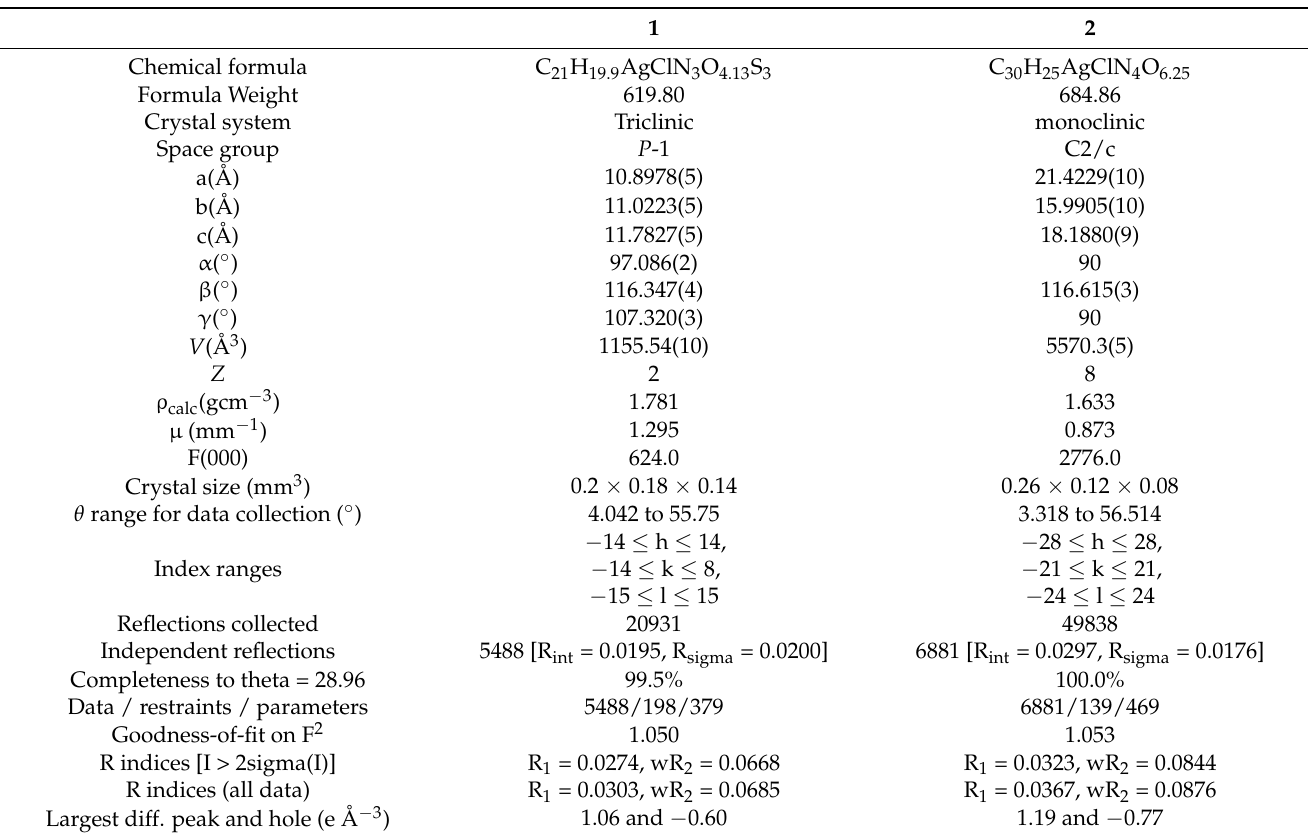
Table 2. Crystal data and structure refinement for complexes 1 and